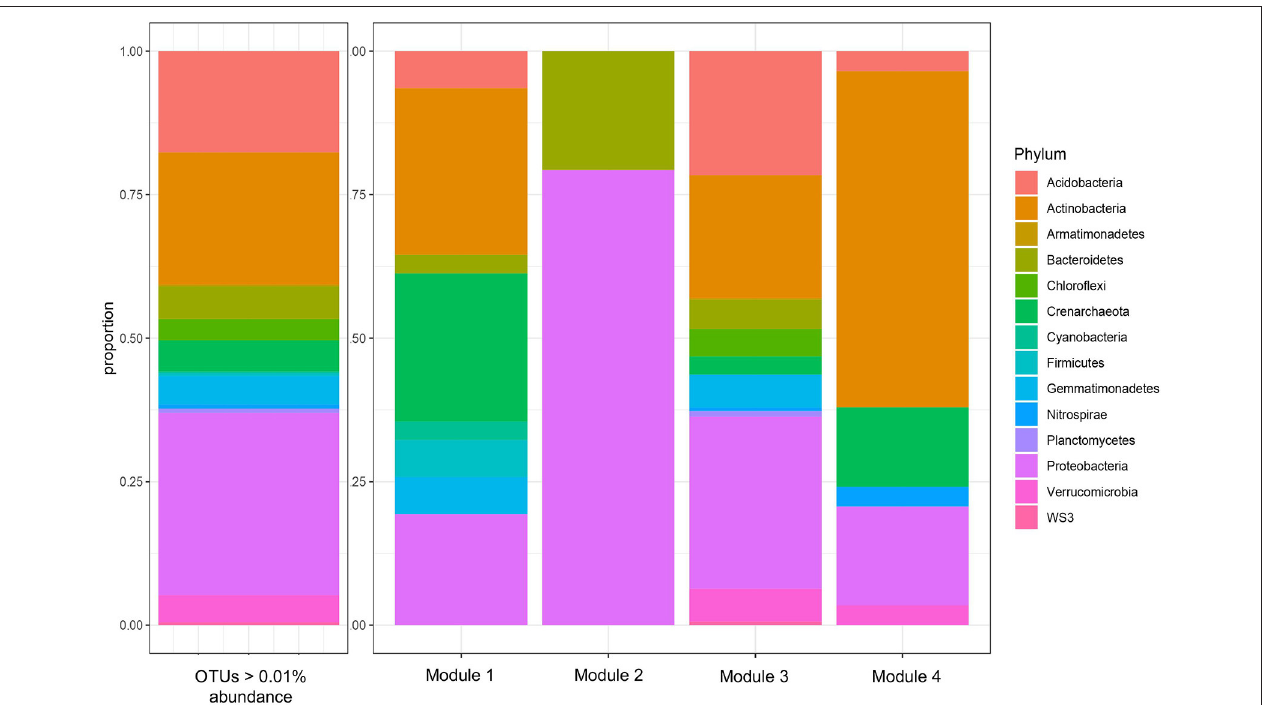
FIGURE 2 | Taxonomic composition, by phylum, of all 16S OTUs above 0.01% abundance, and of the four modules of 16S OTUs identified by WGCNA. The threshold of 0.01% abundance was used determine OTUs to include in the subsequent WGCNA.